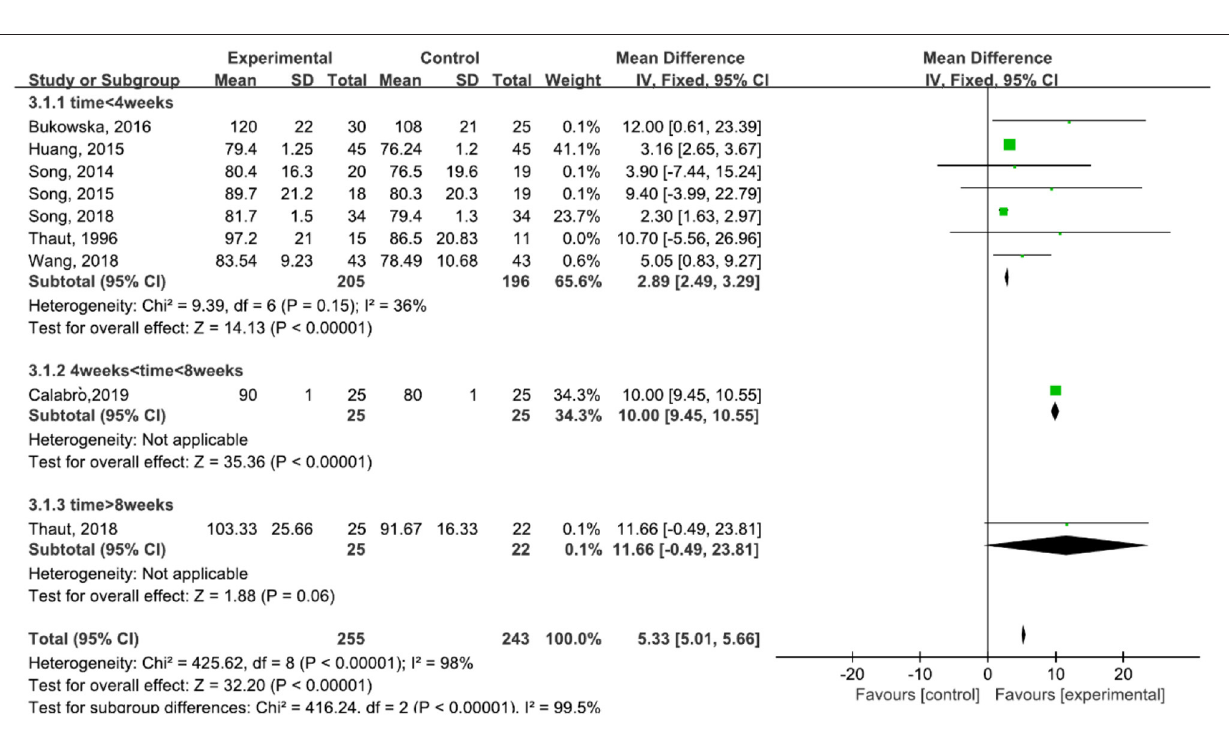
FIGURE 5 | Forest plot showing MD (with 95% CI) for velocity of the included studies comparing the experimental and control